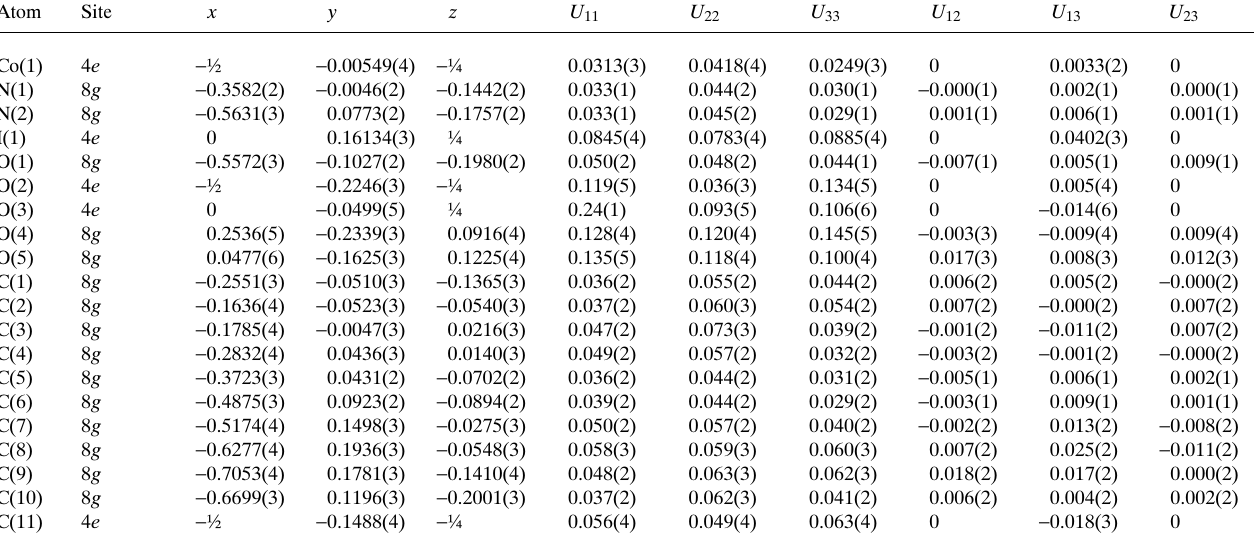
Table 3. Atomic coordinates and displacement parameters (in Å 2 ) .